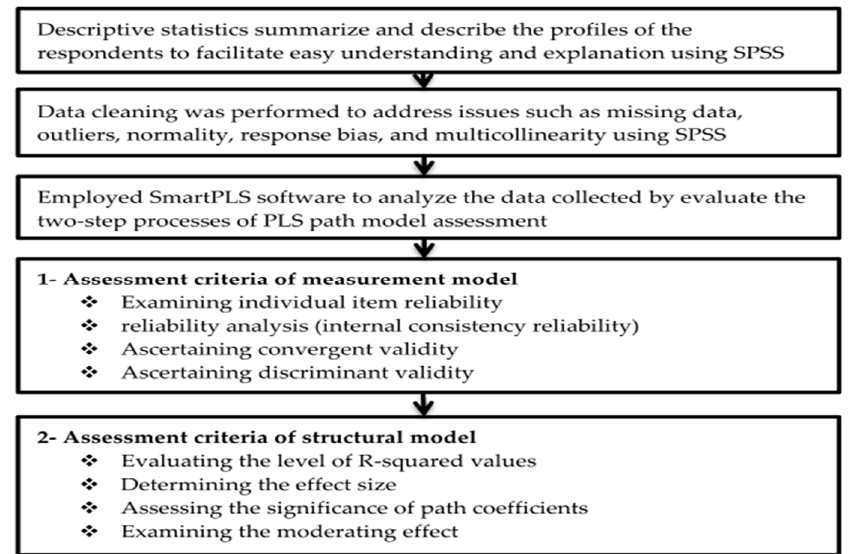
Figure 2. Research Figure 2. Research process.